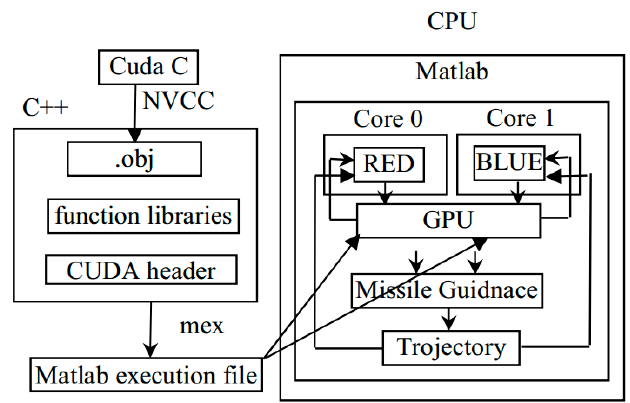
Figure 5. Mixed parallel computing framework of graphics processing unit.